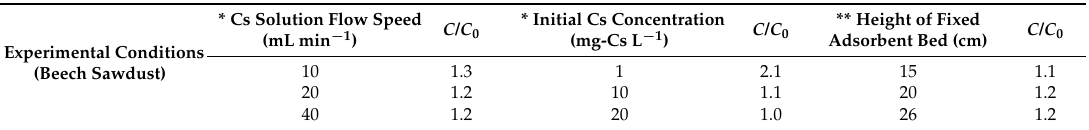
Table 5. C / C 0 obtained from breakthrough curves of beech sawdust for adsorption under various experimental